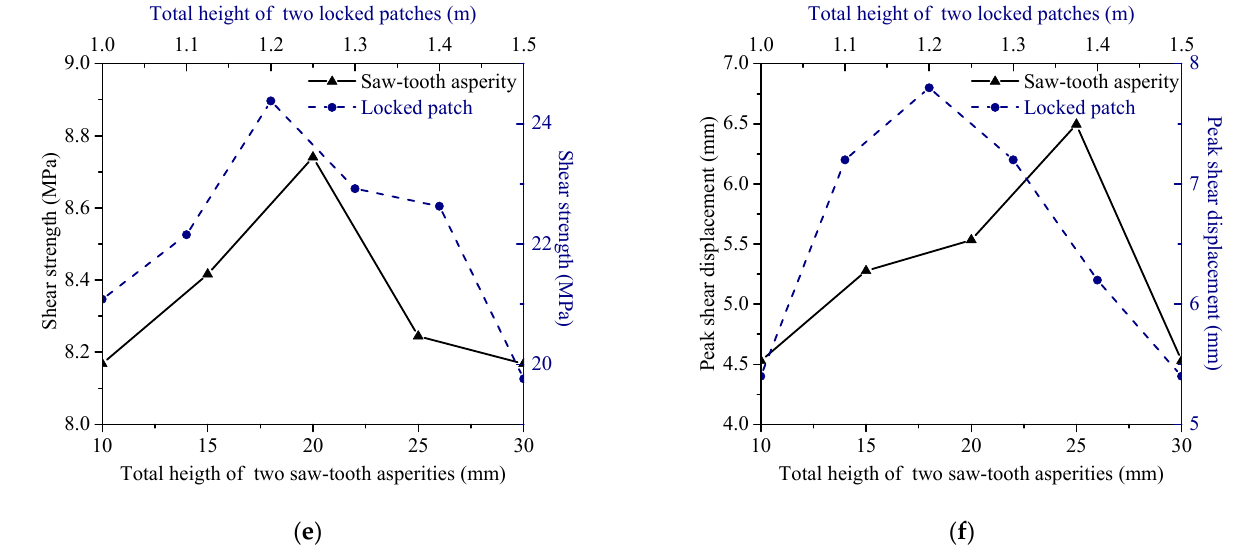
Figure 11. Comparisons between numerical results and experimental results. ( a ) Total length vs. shear strength, ( b ) total length vs. peak shear displacement, ( c ) spacing vs. shear strength, ( d ) spacing vs. peak shear displacement, ( e ) total height vs. shear strength, ( f ) total height vs. peak shear displacement.